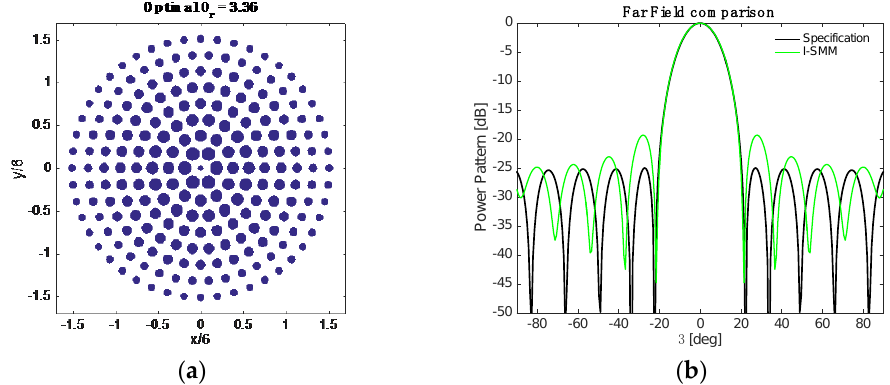
Figure 5. Synthesis of radius values for a GAM F -based lens with unknown permittivity [ 𝜏 = −0.9369 −